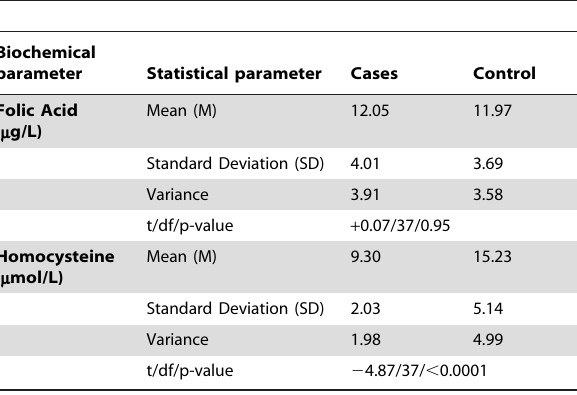
Table 6. Folic acid and homocysteine concentration in cases and controls.